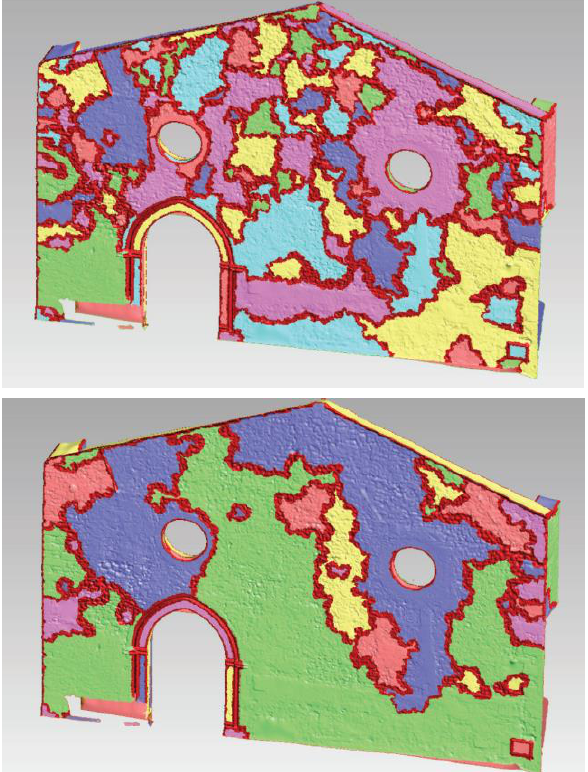
Figure 10 . Feature regions automatically extracted by the high- poly reality-based mesh model: from the top, non-optimized mesh, then optimized mesh with high curvature range extraction (80/100) and optimized curvature range extraction